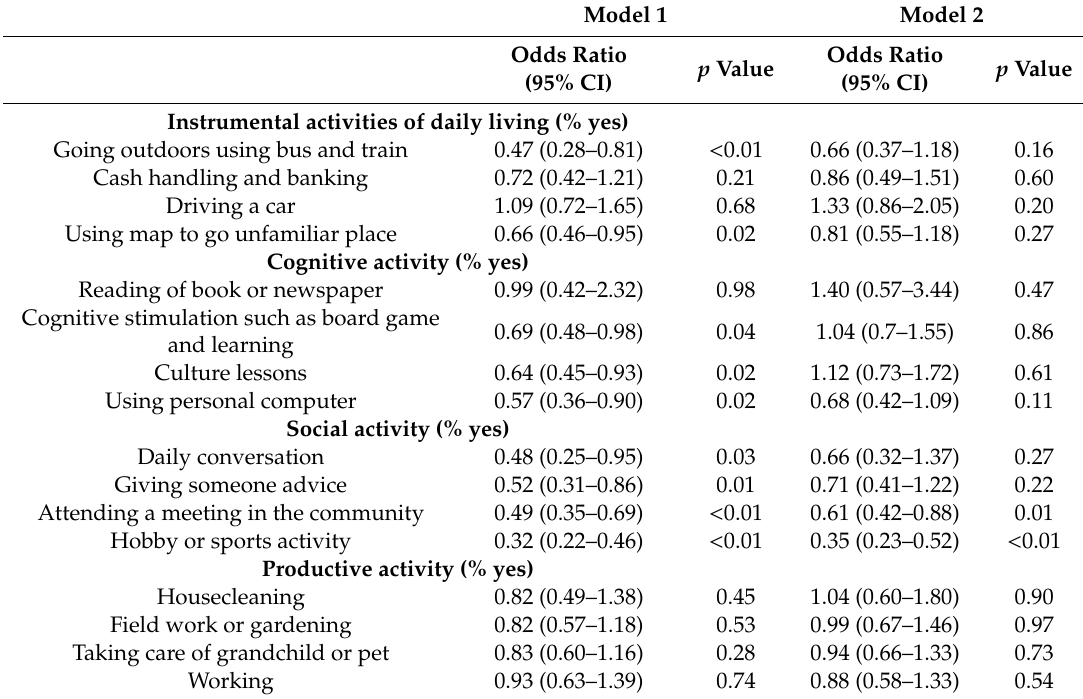
Table 3. Relationships between frailty status and lifestyle activities.